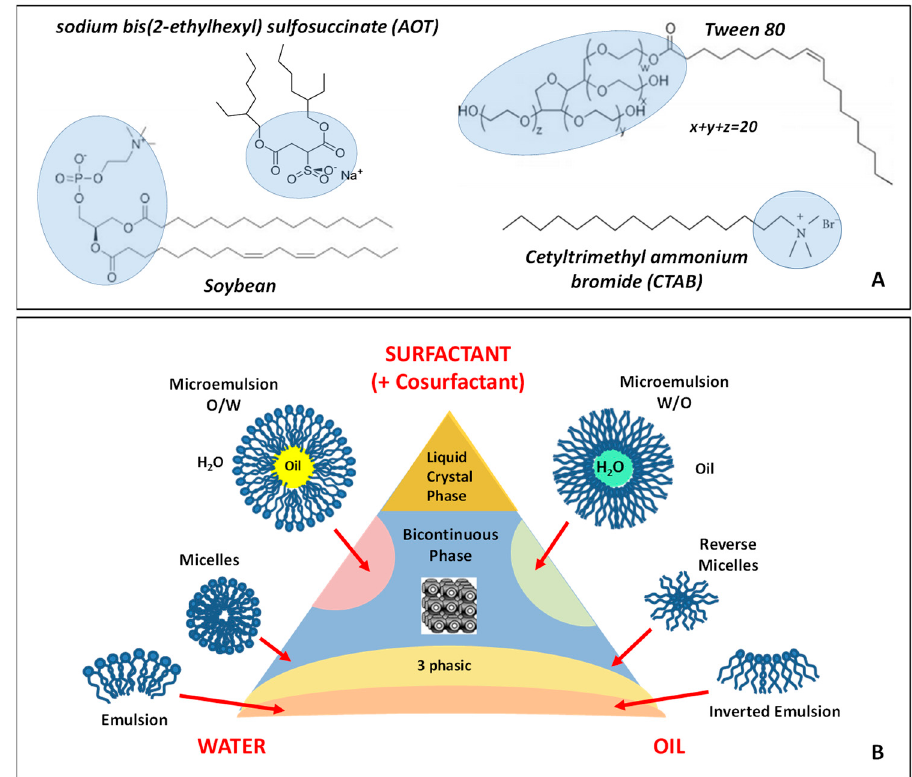
Figure 6. Chemical structure of some of the most important amphiphiles employed for the formation of microemulsions ( A ). Schematic representation of the possible different nanostructures that can be of microemulsions ( A ). Schematic representation of the possible di ff erent nanostructures that can obtained by the self-assembly process in a system composed of water, oil and a surfactant ( B ).